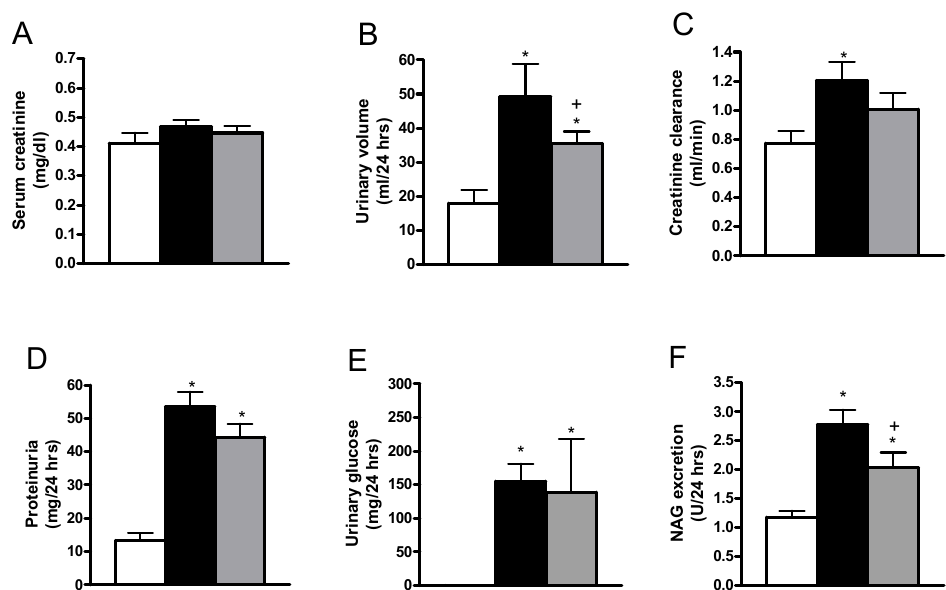
Figure 2. Comparisons of ( A ) serum creatinine, ( B ) urinary volume, ( C ) creatinine clearance, ( D ) proteinuria, ( E ) urinary glucose, and ( F ) urinary excretion of N -acetyl- β - D -glucosaminidase (NAG) for the control, untreated diabetic and allicin-treated diabetic groups. White bars, black bars and grey bars indicate the control, untreated diabetic and allicin-treated diabetic groups, respectively. Data represent the average of values from all the animals ( n = 6) in a given group ± SEM (* p < 0.05 vs. the control group; + p < 0.05 vs. the diabetic groups).